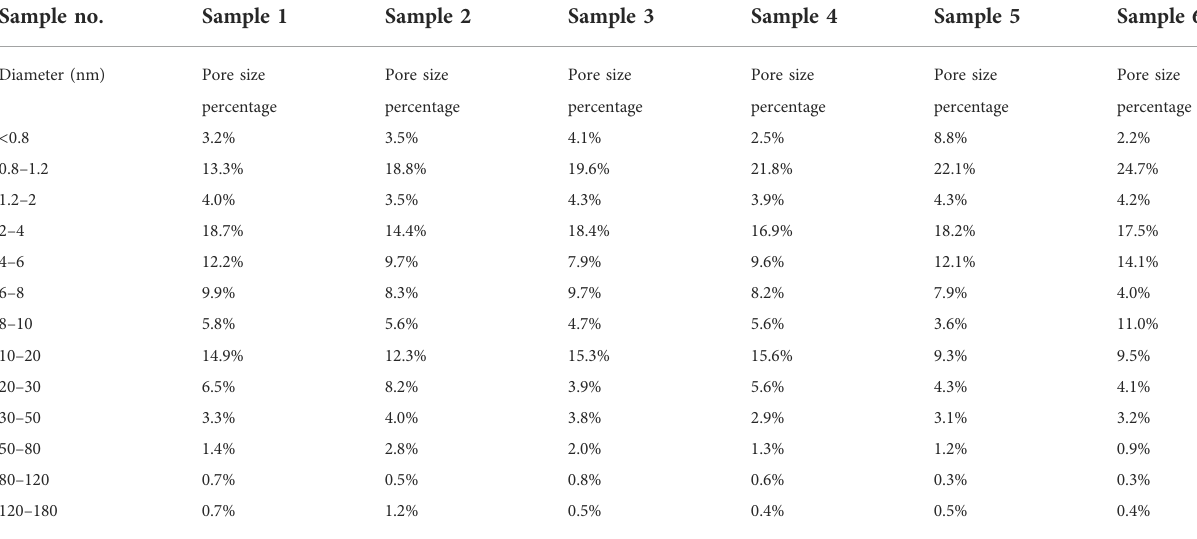
TABLE 3 Pore size distribution of tuffaceous rocks. Sample